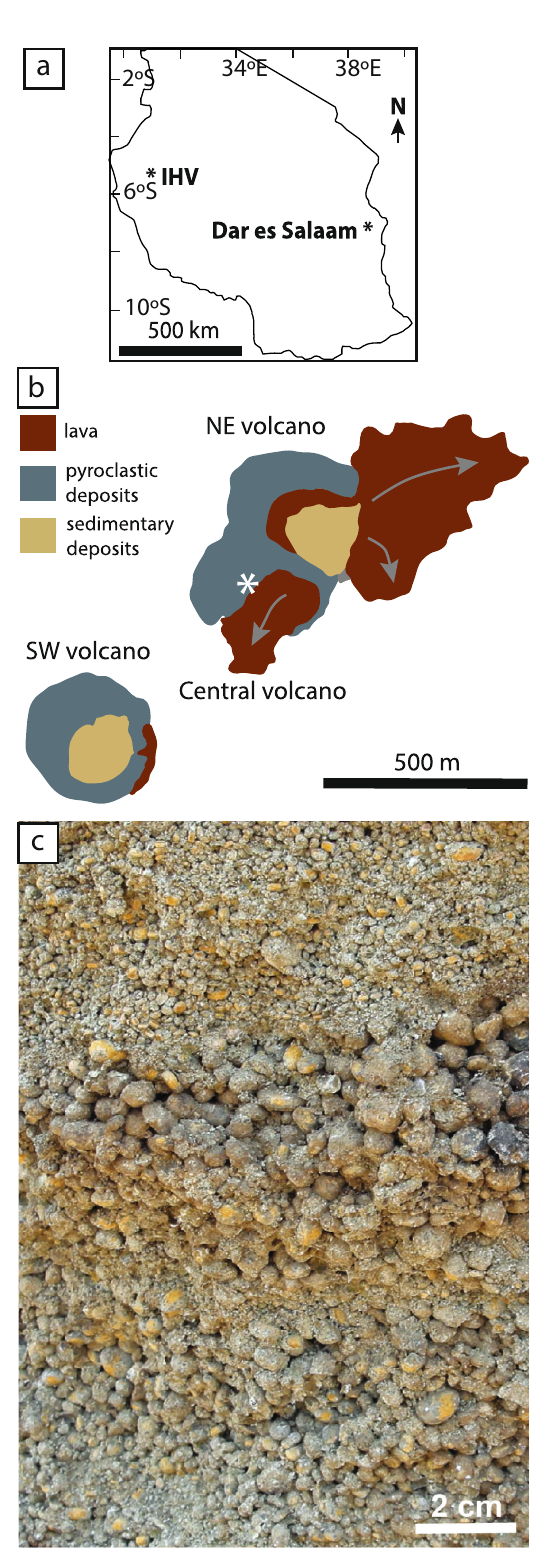
Fig. 1 The Igwisi Hills volcanoes (IHV), Tanzania. a Outline map of Tanzania with the city Dar es Salaam and the Igwisi Hills volcanoes marked. b Geological map of the Igwisi Hills volcanoes with our sample site marked by the asterisk ( − 4.887884° latitude, 31.933439° longitude). The map is adapted from Shaikh et al. 47 , with permission. c Field photograph taken from Brown et al. 4 of the bedded pyroclastic fallout deposits sampled as part of this study that make up part of the pyroclastic cone on the west of the Central volcano. The deposits are composed of clast-supported pelletal lapilli. For further detailed deposit descriptions the readers are referred to Brown et al.